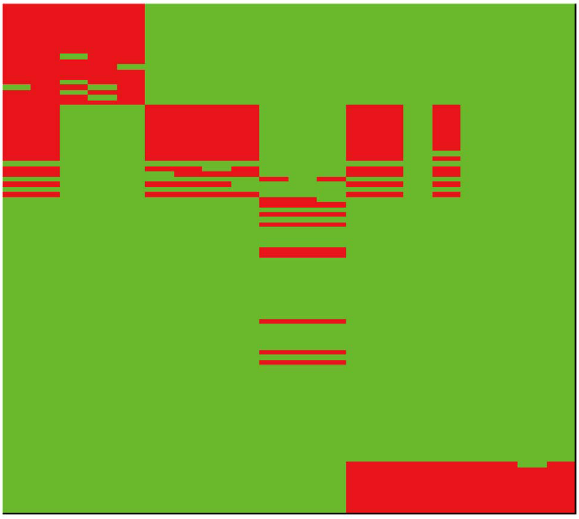
Figure 2. The plot of the same synthetic data matrix after data are dichotomized. The boundaries between the signals (red) and non-signals (green) are apparent.